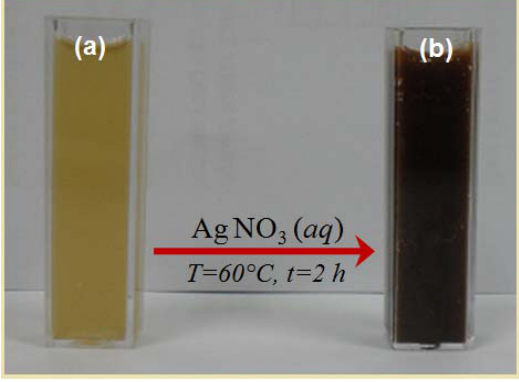
Figure 1. Photograph of ( a ) Callicarpa maingayi and ( b ) Ag/ Callicarpa maingayi emulsion after 48